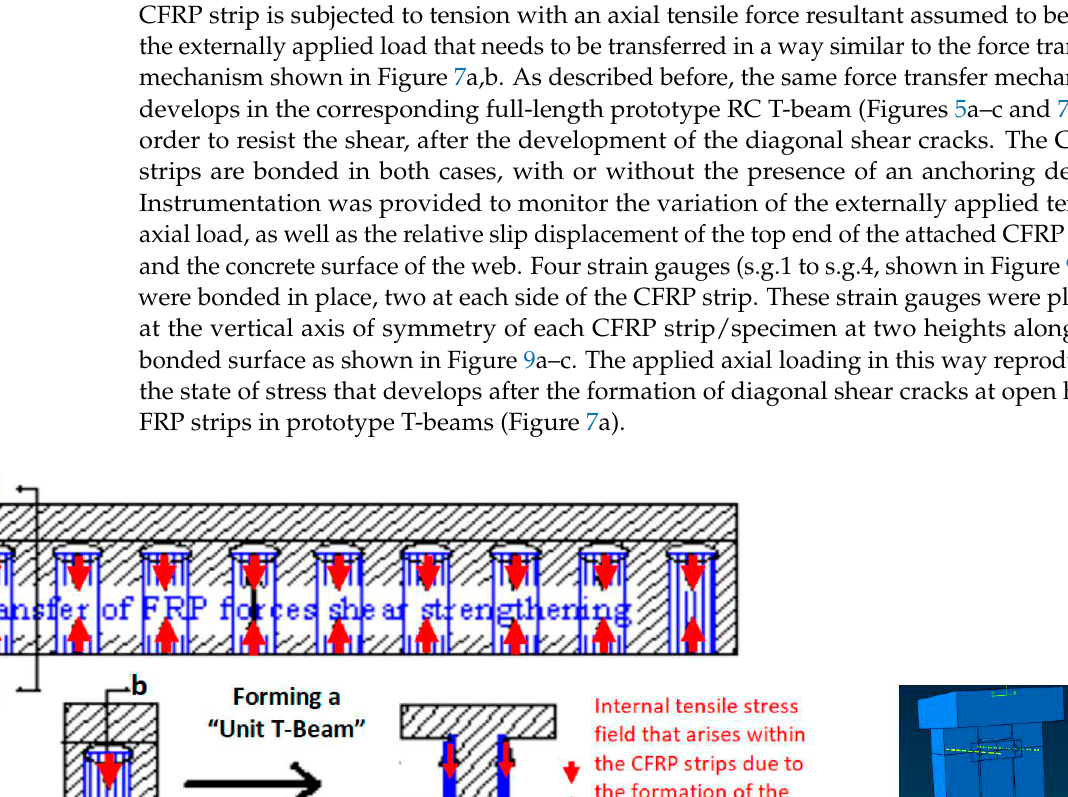
Figure 7. ( a ) Force transfer mechanisms for externally bonded CFRP strips for shear retrofit and the concept of forming a “unit T-beam” specimen. ( b ) Three-dimensional drawing of a limited length unit “T-beam” specimen including a single CFRP strip external transverse shear reinforcement with a steel anchoring device together with the externally applied load.